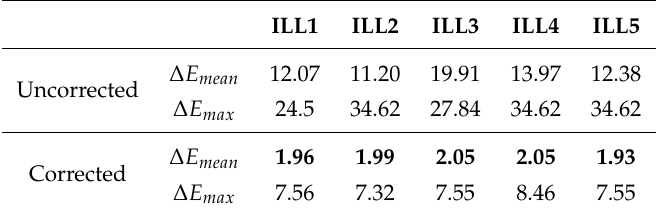
Table 3. Color difference of testing samples under five different illuminances before and after correction.